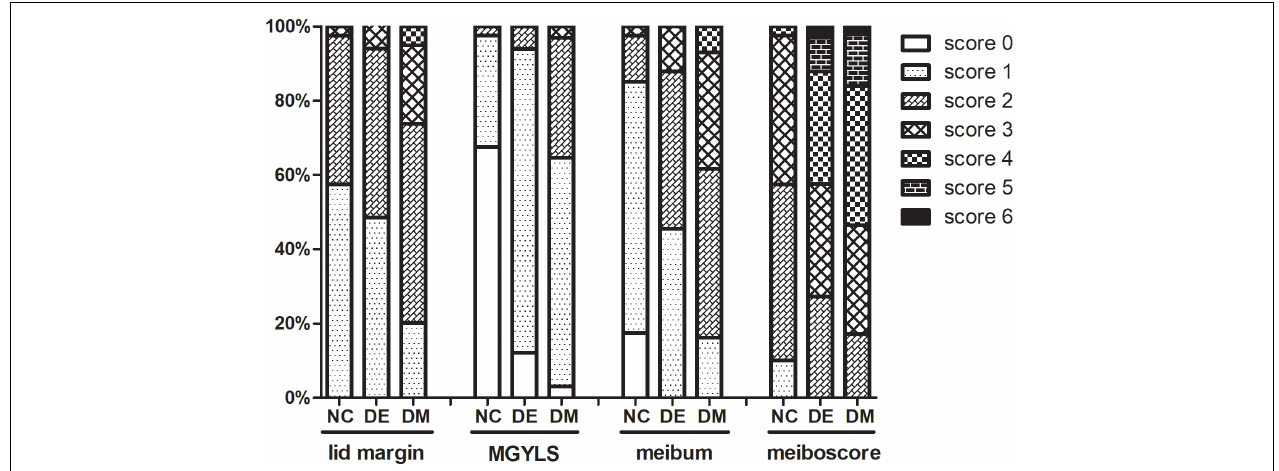
FIGURE 1 | The stacked percentage column chart showing the detailed distribution of meibomian gland parameters. NC, normal control; DE, dry eye; DM, diabetes mellitus; MGYLS, meibomian gland yielding liquid secretion.